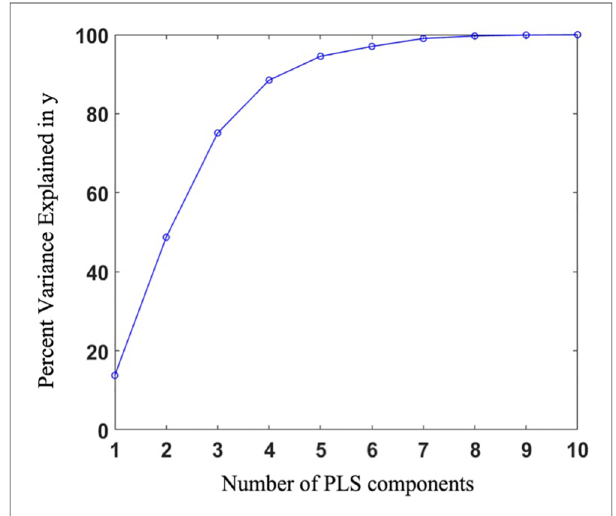
FIGURE 5 Percentage of variance explained in the outcome as a function of the number of shape